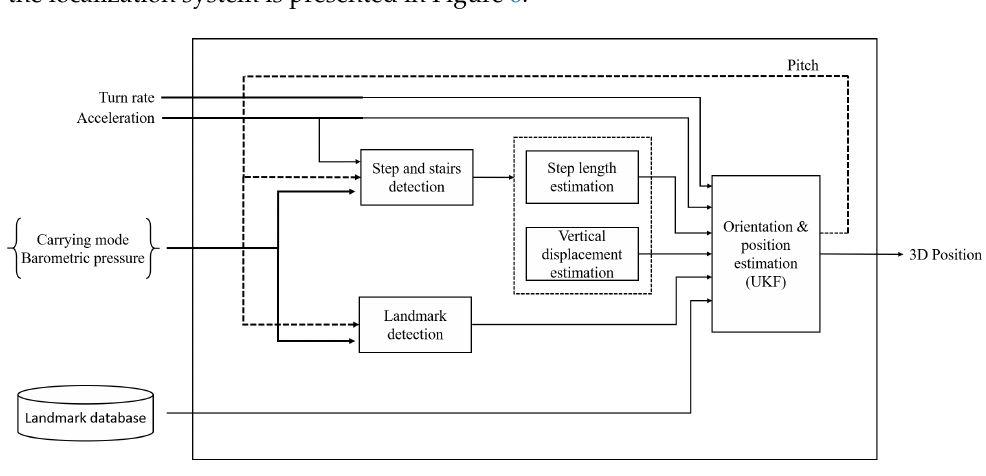
Figure 6. Block diagram of the smartphone-based localization system with several possible carrying modes.